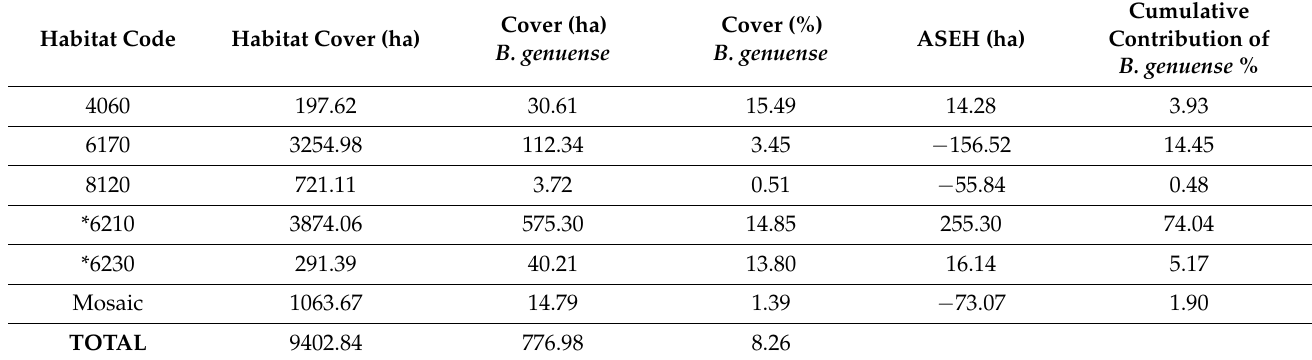
Table 2. Results from overlay analysis. From left to right in the table: habitat codes correspond to Alpine and Boreal heaths (4060), Alpine and subalpine calcareous grasslands (6170), Semi-natural dry grasslands and scrubland facies on calcareous substrates ( Festuco-Brometalia ) (* important orchid sites) (6210*), Species-rich Nardus grasslands, on siliceous substrates in mountain areas and submountain areas, in Continental Europe (6230*) and Calcareous rocky slopes with chasmophytic vegetation (8210); total hectares of each habitat; hectares covered by Brachypodium genuense ( B. genuense ) in each habitat; relative cover percentage of B. genuense ; differences between realized cover and expected cover (ASEH), where the negative values indicate that the B. genuense is less than what was expected (8.26% in each habitat), while positive value indicate a higher cover compared to the expected ones; percentage of B. genuense patches in each habitat compared to the total hectares covered by the species.